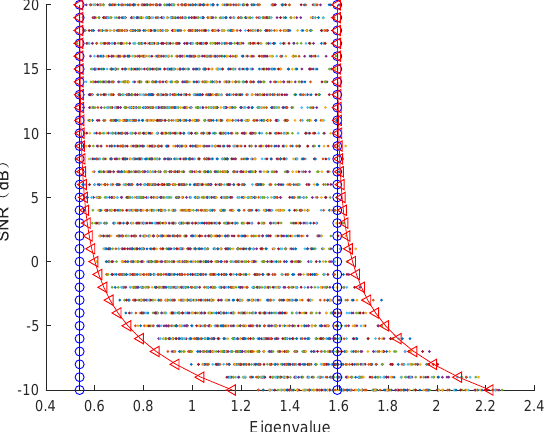
Figure 4. Empirical eigenvalue distribution with the effect of noise at different SNR levels when p b = 1, T = 10, M = 10. The blue circles represent the boundaries of the eigenvalues obtained from (25) M K and (26). The red triangle represent the boundaries from (30) and (31) that integrate the effect of noise